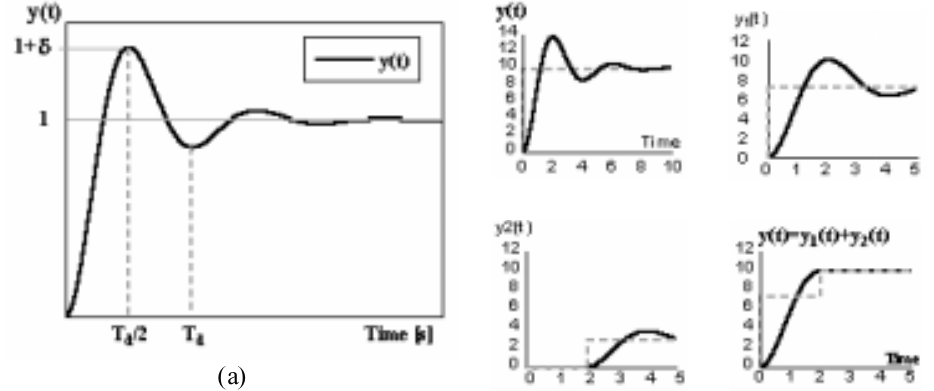
Fig. 2. (a) Step response of an underdamped system characterized by the overshoot and time period T d . (b) The Posicast effect compared to the underdamped response: the vibration induced by the first step is cancelled by a later portion of the step. Conditions ω n = 1.626 rad s − 1 , ξ = 0.3.